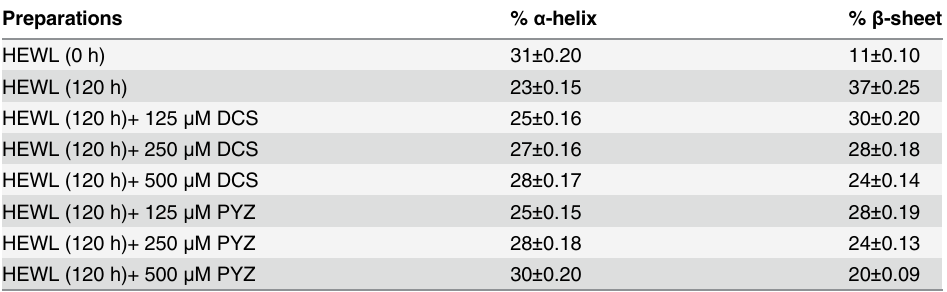
Table 2. The secondary structural contents of HEWL incubated in absence and presence of different concentration of DCS and PYZ as calculated from